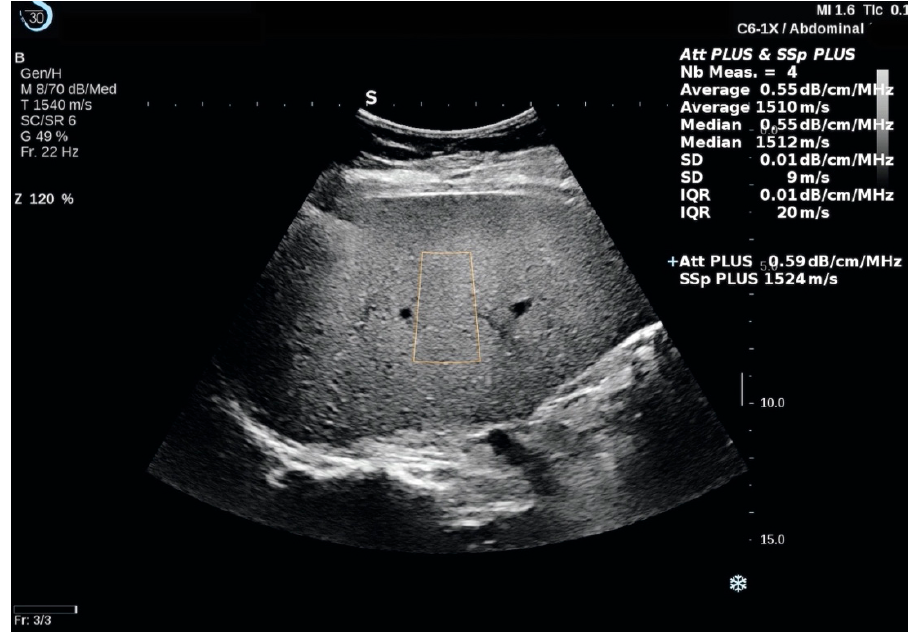
Figure 2. The Sound Speed Plane-Wave Ultrasound (SSp.PLUS) and the Attenuation Plane-Wave Ultrasound (Att.PLUS) measurements performed in a patient with liver steatosis using the Aixplorer MACH 30 platform. The Region of Interest (ROI) is positioned at a fixed depth, in an area free of major vessels or other structures. A measurement window with statistical values (Mean, Median, SD, and IQR) is displayed on the right side of the main screen. The results are expressed in m/s for SSp.PLUS and in db/cm/MHz for Att.PLUS.